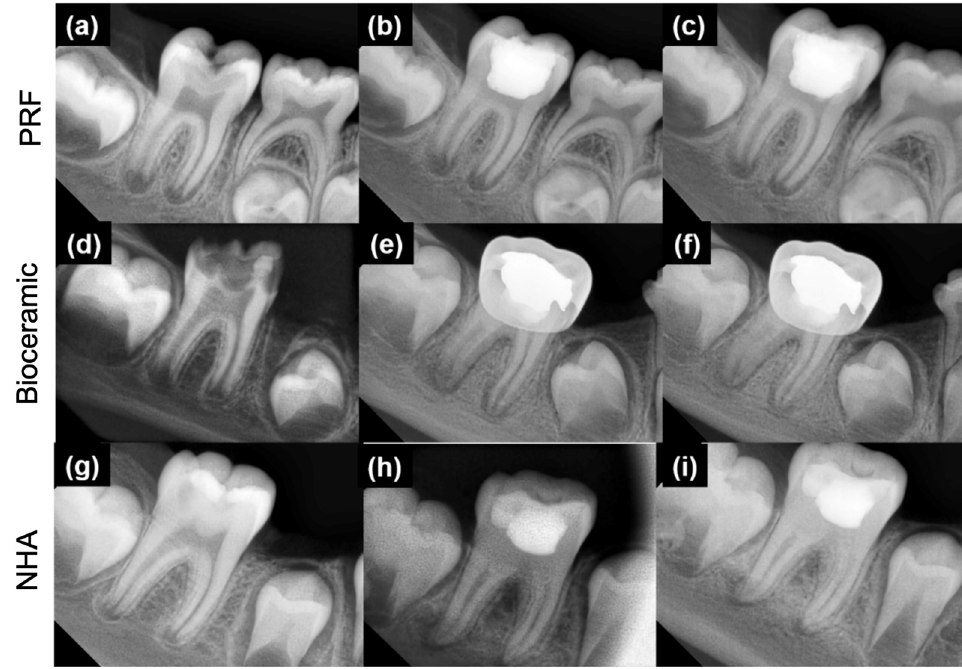
Figure 4. ( a ) Preoperative radiograph of an immature mandibular molar; ( b ) no complete apical closure at 6 months; ( c ) no complete apical closure at 12 months “continued apical closure”; ( d ) preoperative radiograph of an immature mandibular molar; ( e ) no complete apical closure at 6 months “continued apical closure”; ( f ) complete apical closure at 12 months; ( g ) preoperative radi- ograph of an immature mandibular molar; ( h ) complete apical closure at 6 months; ( i ) complete apical closure at 12 months. Table 1. Age, sex and radiographic evidence of root canal growth in the three tested group at 6- and 12-month follow-ups. * p < 0.05.